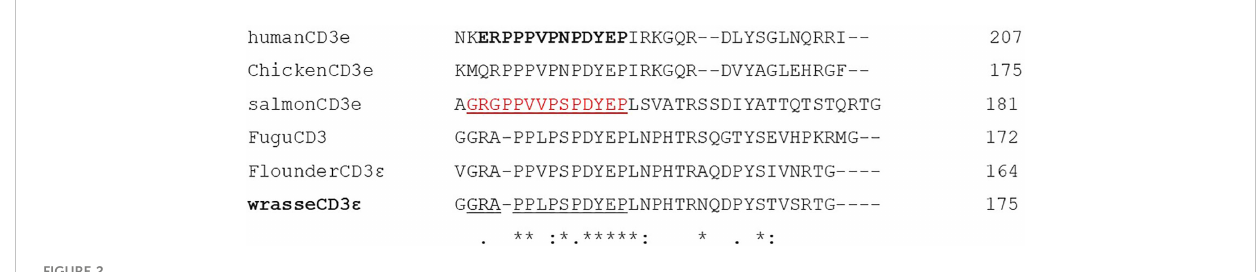
FIGURE 2 Alignment of the cytoplasmatic tail of wrasse CD3 ϵ and corresponding sequences from human, chicken, salmon, fugu, and fl ounder. Residues identical in all sequences, highly conserved sequences, and conserved sequences are indicated by stars (*), colons (:), and periods (.) respectively. A commercial human antibody was raised against the peptide indicated in bold. In salmon, a successful antibody was raised against the peptide indicated in red. The corresponding sequence in wrasse is underlined and was used to raise an antibody (anti-wrasse CD3 ϵ